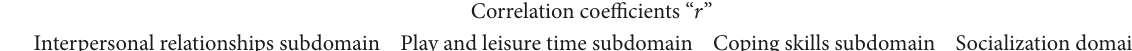
Table 5: A correlation analysis between the VEP parameters over the Oz electrode and the VABS-II standard scores in the socialization domain and its